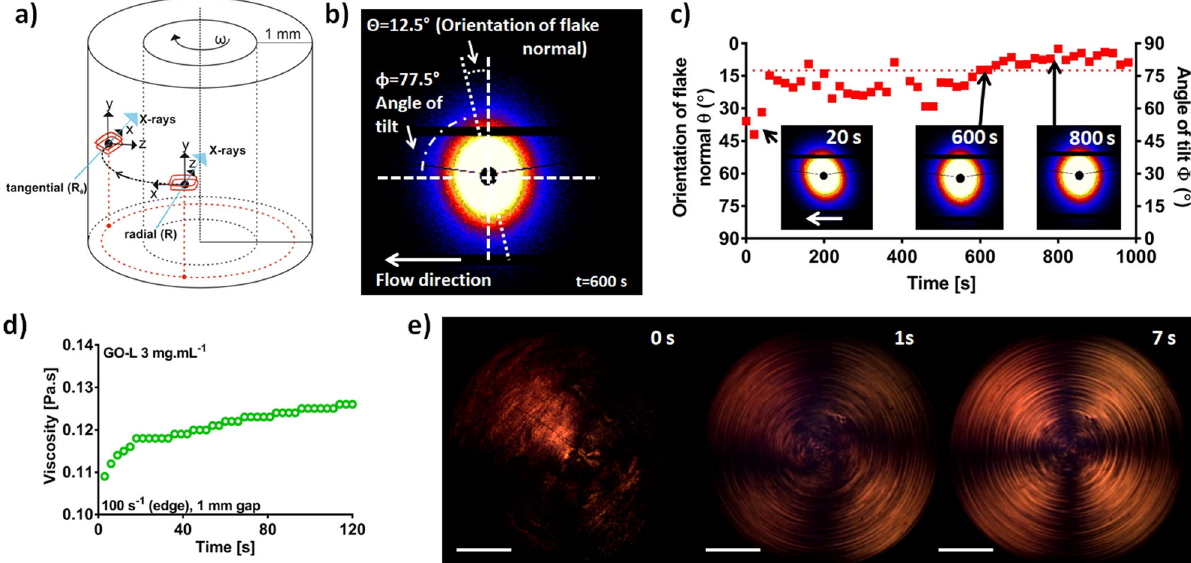
Fig. 4 Rheo-SAXS of 3 mg ml − 1 GO-L. a A coaxial cylinder shearing cell in Rheo-SAXS measurements with two probed locations in the cell depicted: Radial (R) and Tangential (R θ ). The Cartesian coordinate system associated with the dispersion fl ow ( x , y , and z corresponds to fl ow, vorticity and shear gradient direction, respectively, see also Fig. 1c) was mapped onto the coaxial cylinder cell, where the arrowed black dotted line reproduces a trace of fl ow and a movement of the Cartesian coordinates. b 2D SAXS pattern obtained at 600 s time point, illustrating the relationship between the conventional tilt angle of SAXS pattern ( Φ ) and orientation of the fl ake normal ( Θ ). Direction of shear is depicted by the white arrow. c Orientation angle of 3 mg mL − 1 GO-L sheared in coaxial cylinder geometry at ω = 4.17 rad s − 1 (shear rate of 100 s − 1 ) with a 1 mm gap, in the radial direction, as a function of time taken during the shear experiment. Dashed line shows alignment of 12.5°, which corresponds to the observed offset between the MCs in the Rheo-SIPLI. The representative 2D SAXS patterns of sheared GO-L corresponding to three different time points (three different frames) show evolution of scattering pattern. Direction of shear is depicted by the white arrow. d Time sweep parallel-plate rheology of GO-L at 3 mg mL − 1 ( ω = 8 rad s − 1 , edge shear rate of 100 s − 1 ), rheopecty is observed during the course of the measurement. e Representative SIPLI data showing the evolution of patterns during vortex formation for the fi rst 7 s of measurements. Scale bar on SIPLIs depicts 5.86